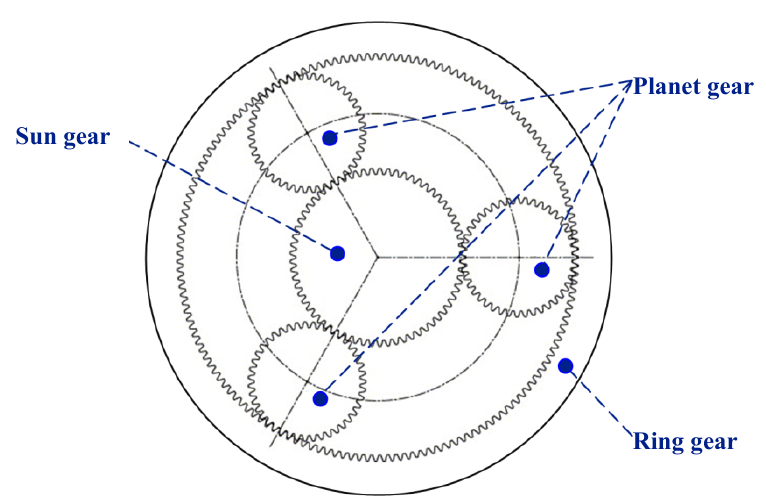
Figure 1. Schematic of an elementary planetary gear set having three planet